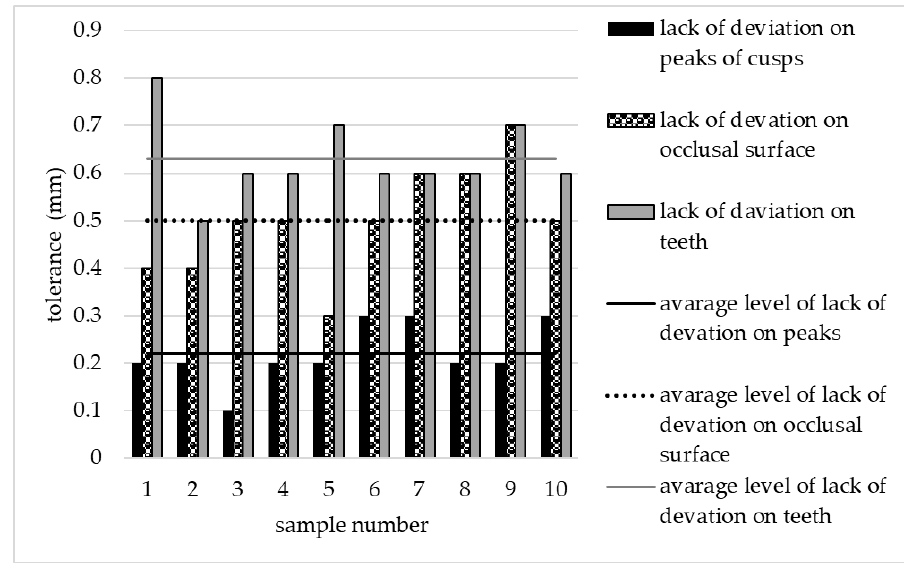
Figure 3. The deviation of the samples on three levels: peaks of cusps, occlusal surface, and teeth’s crowns.